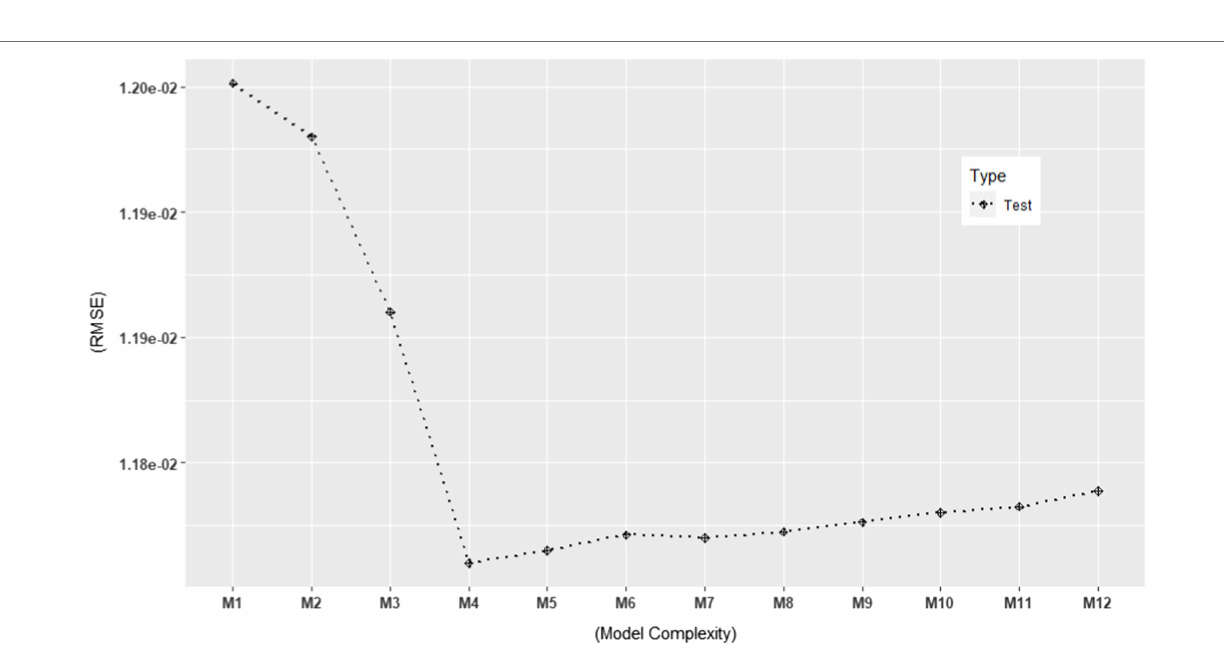
FIGURE 6 | Test set RMSE for 12 models using the 2019 NSDUH data ( N = 6,696). The RMSE values are consistent with those in Table 2